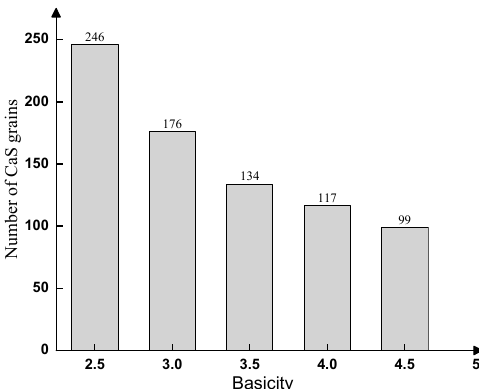
Figure 7. Number of CaS grains in molten slag.